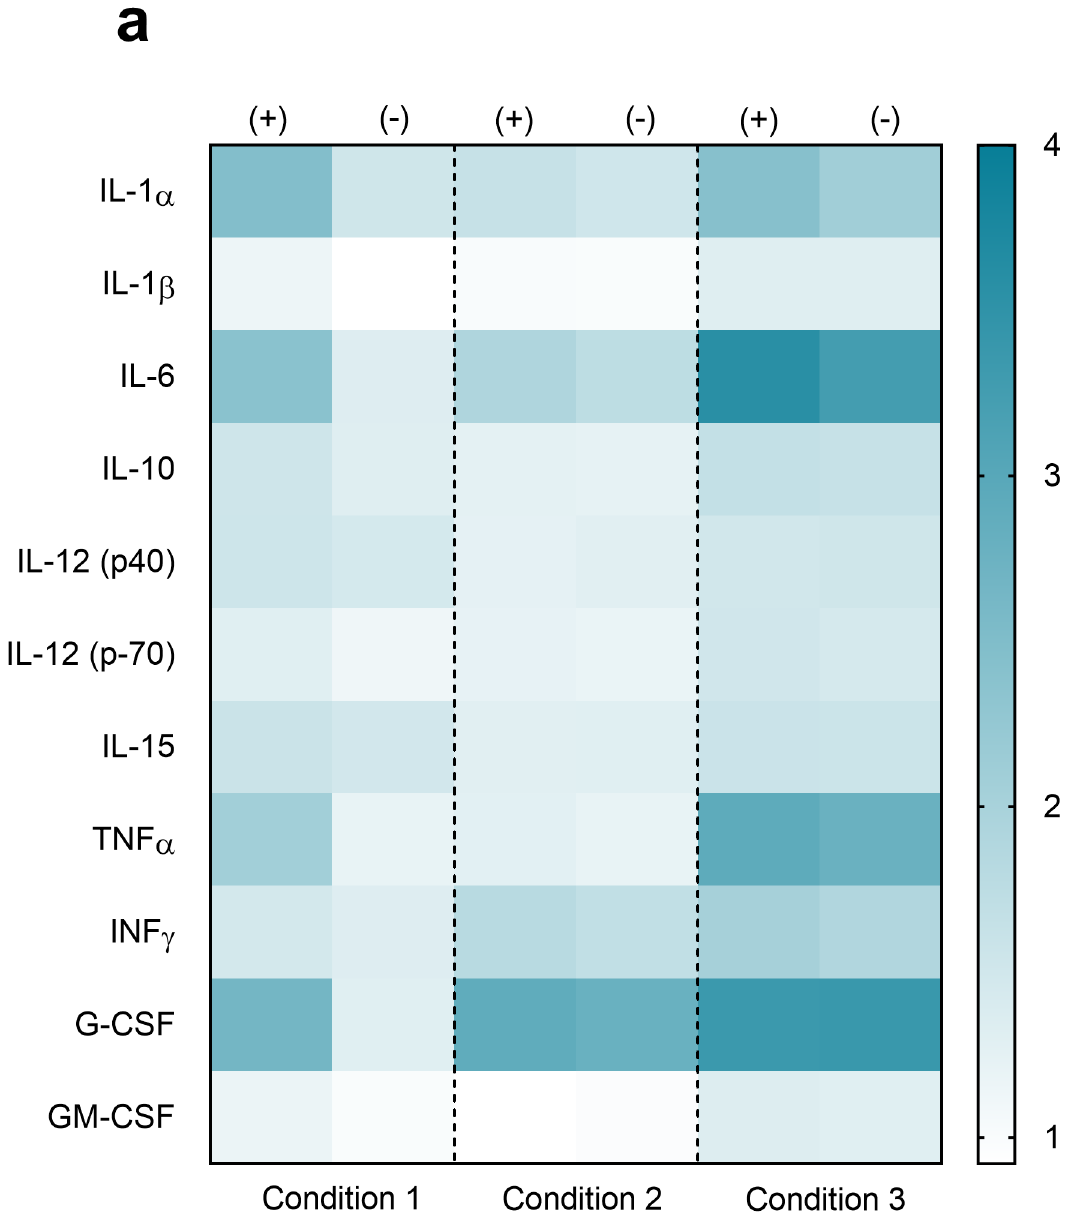
Fig 6. Heat map distribution of cytokines in each condition. Displays intensity profile of cytokine expression in TLR4(+) cells in conditions 1, 2, and 3, both with (+) and without (-) LPS stimulation. LPS condition is labeled on the upper axis, while serum condition is labeled on the lower axis. Scale bar indicates that 1 is the lowest (white color) and 4 is the highest (dark teal) intensity. Values were plotted as the mean value of the base 10 logarithm of median fluorescence intensity, n = 3.